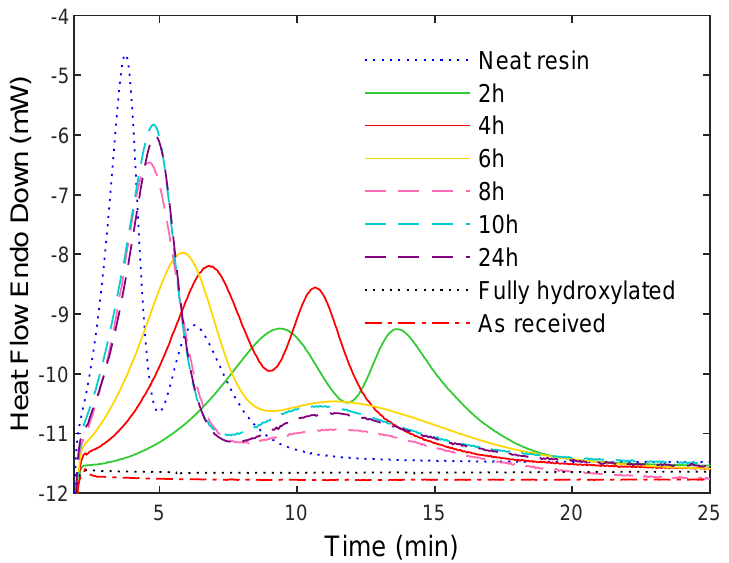
Figure 5. Comparison of polymerization and crystallization heat flow curves of the pure resin during isothermal synthesis at 180 ◦ C with that of PA6/glass particle composites containing particles calcined for different times ranging from 0 h (fully rehydroxylated) to 24